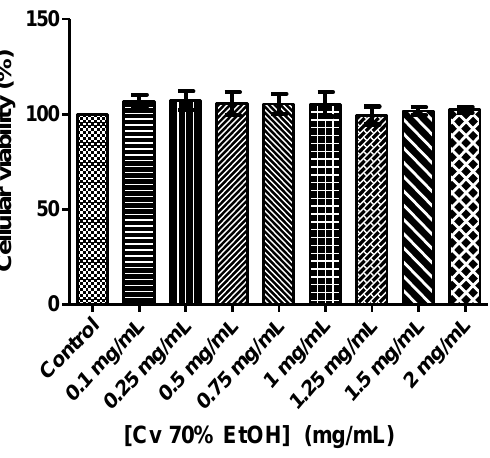
Figure 2. Effect of Crepis vesicaria subsp. taraxacifolia ethanolic extract on macrophages cell viability (RAW 264.7 cells). Each result represents the mean ± SD (minimum of three independent assays, performed in duplicate). The statistical tests were performed with p < 0.05 compared to control.